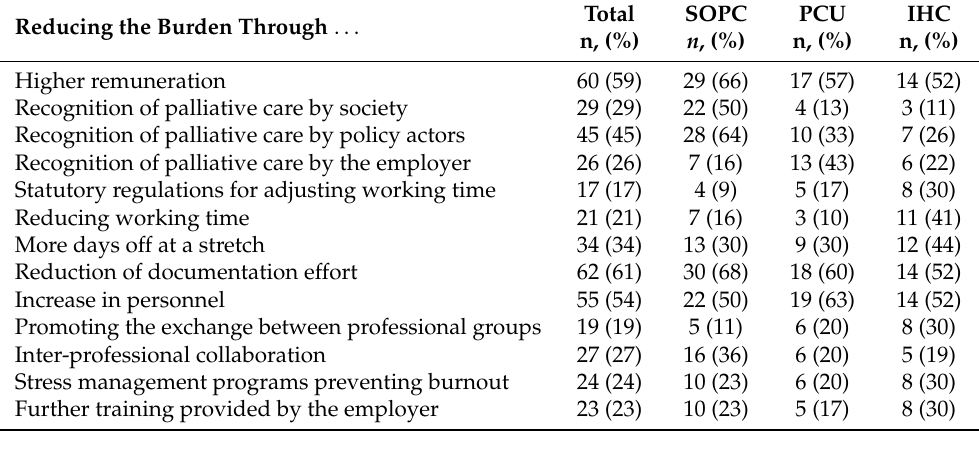
Table 7. Reducing stress in daily work. Table 7 . Reducing stress in daily work .